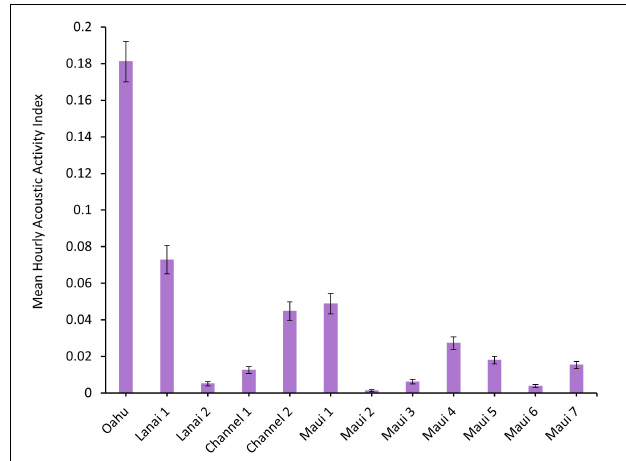
FIGURE 2 | Mean hourly Acoustic Activity Index (AAI), ranging from 0 to 3.5, of each Ecological Acoustic Recorder (EAR) deployment. Error bars represent the standard error of the mean ( ±